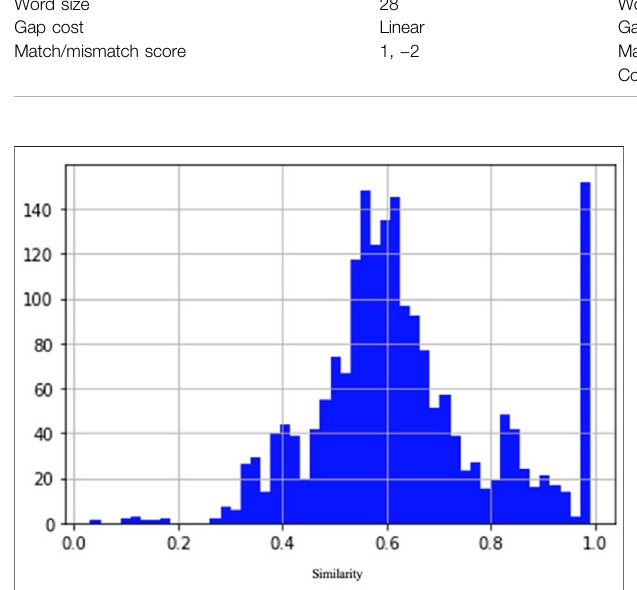
FIGURE 2 | Distribution of similarity between pairs of examples in the data set. The number of pairs is proportional to similarity.